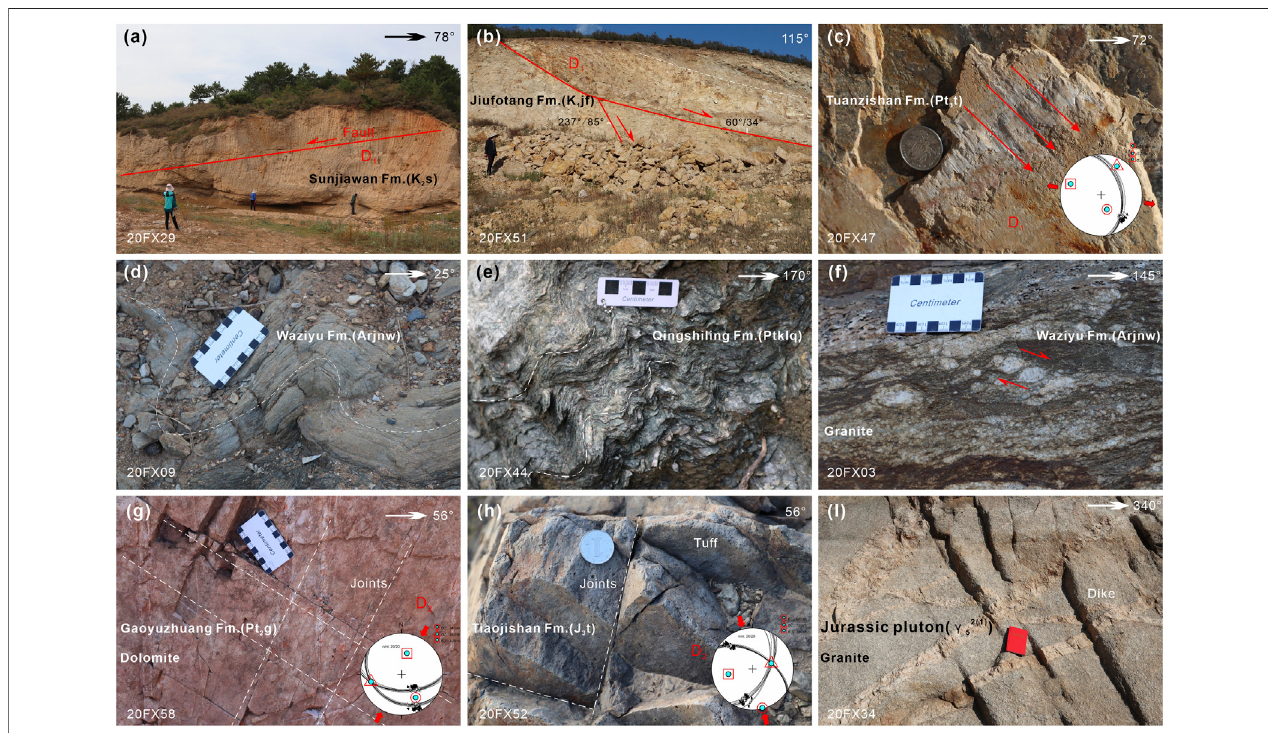
FIGURE6 | Field photographs ofthe Fuxin Basin, showing structural patterns, mesoscopic structures, and kinematics. (A) Normal fault dipping to thenortheast in the Shahai Formation. (B) Normal fault cutting the Jiufotang Formation. (C) Slickenside on fault plane cutting the Neoproterozoic basement.; (D) Folds in the Archean basement. (E) FoldsintheProterozoicbasement. (F) Porphyryclastsingraniticmyloniteshowingdextralshearing. (G) JointscuttingNeoproterozoicdolomite. (H) Joints developed within Late Jurassic Tiaojishan tuffaceous rocks. (I) Felsic dykes truncating granite in the core of the Yiwulvshan MCC to the east of the Fuxin